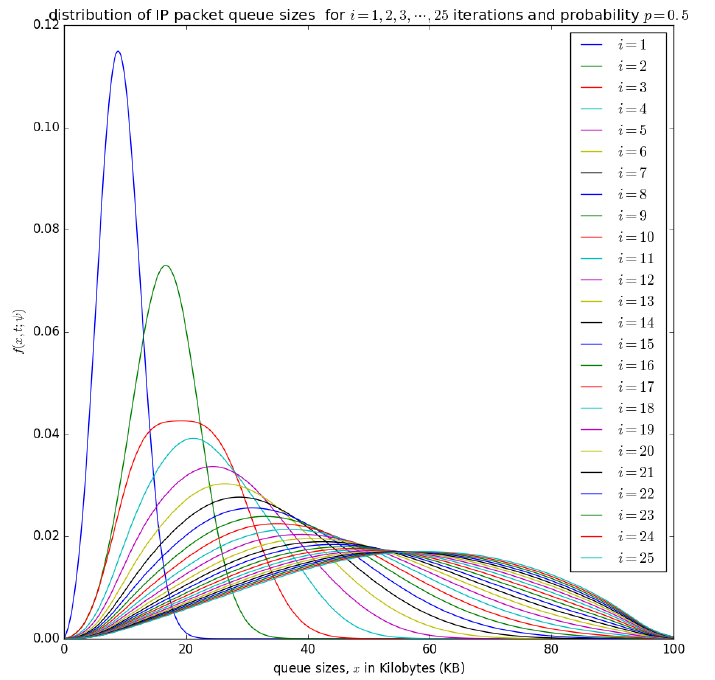
Figure 15. The distribution of the aggregation queue size, f ( x , t ; ψ ) if p = 0.5 for consecutive iterations as in Equation (18) i = 1 . . .